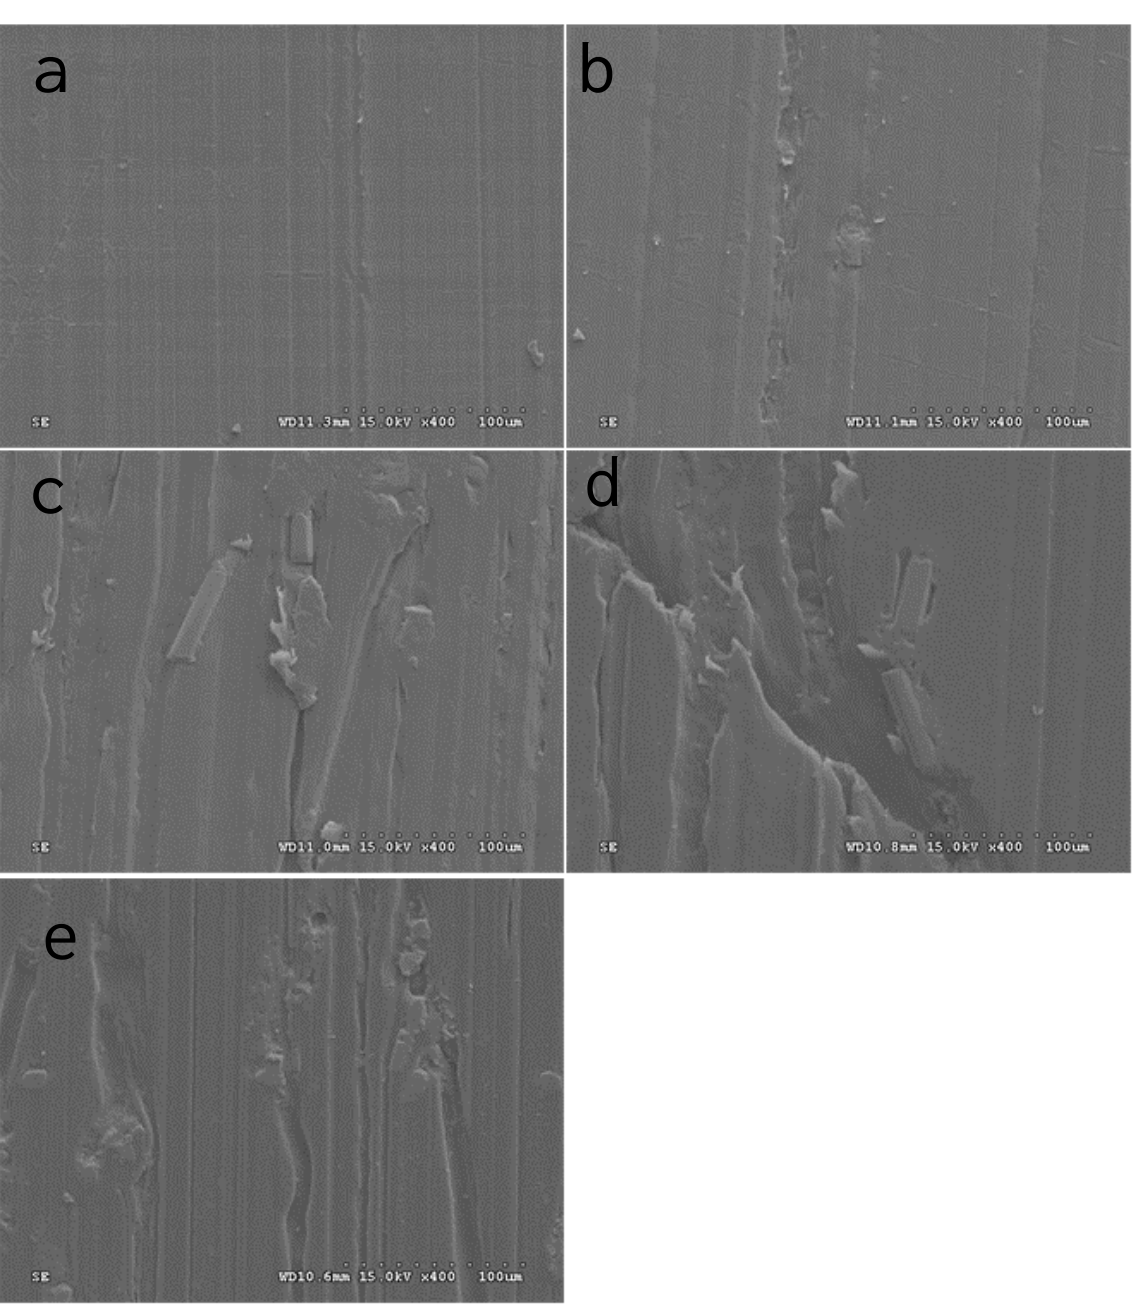
Figure 8: Scanning electron microscopy (SEM) micrographs taken of worn surfaces of (a) pure PEEK,(b) PEEK/ SBF composite with 2.5 wt.% SBFs, (c) PEEK/ SBF composite with 5 wt.% SBFs, (d) PEEK/ SBF composite with 7.5 wt.% SBFs and (e)PEEK/ SBF composite with 10 wt.%